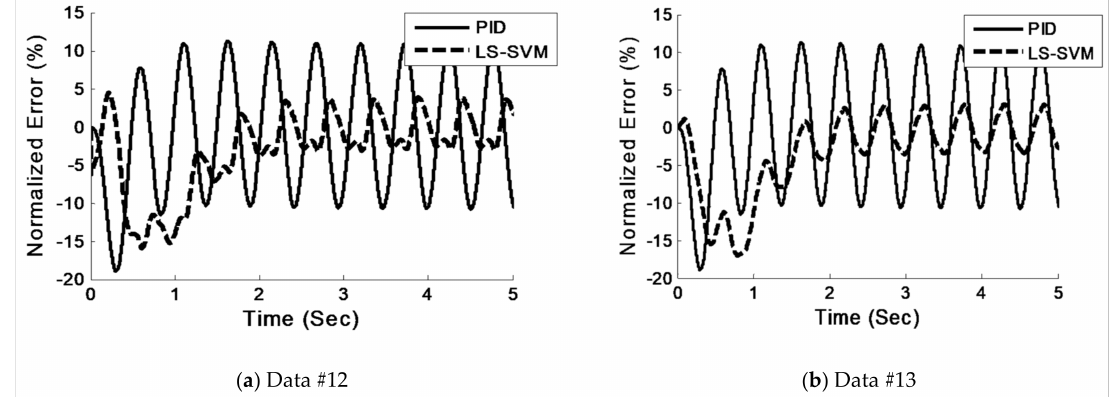
Figure 10. Comparison of the normalized errors of Model 3 in di ff erent